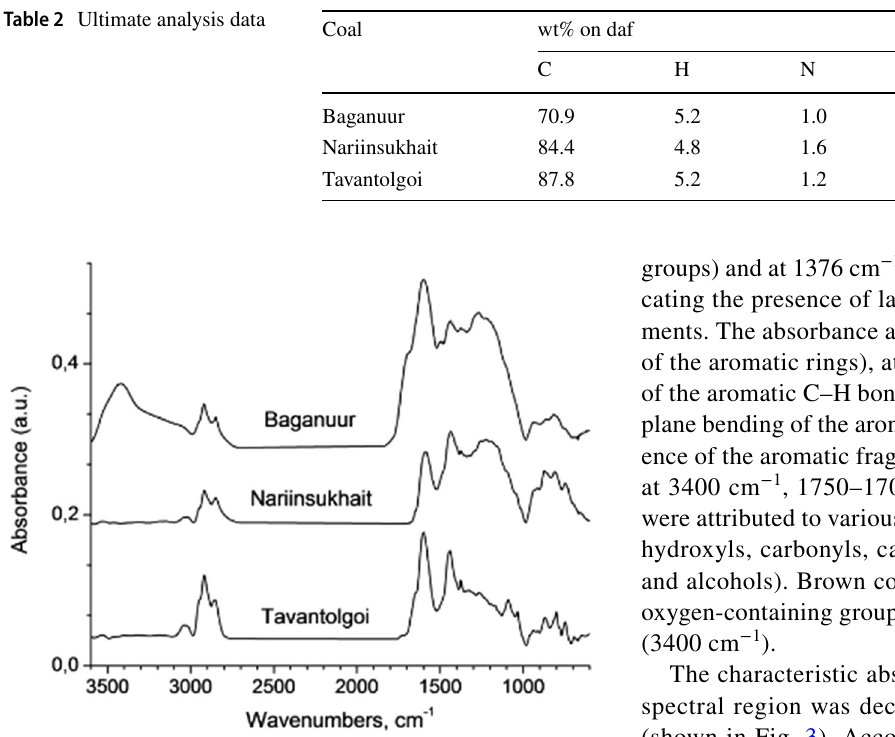
Fig. 2 The FTIR spectra of Mongolian coals